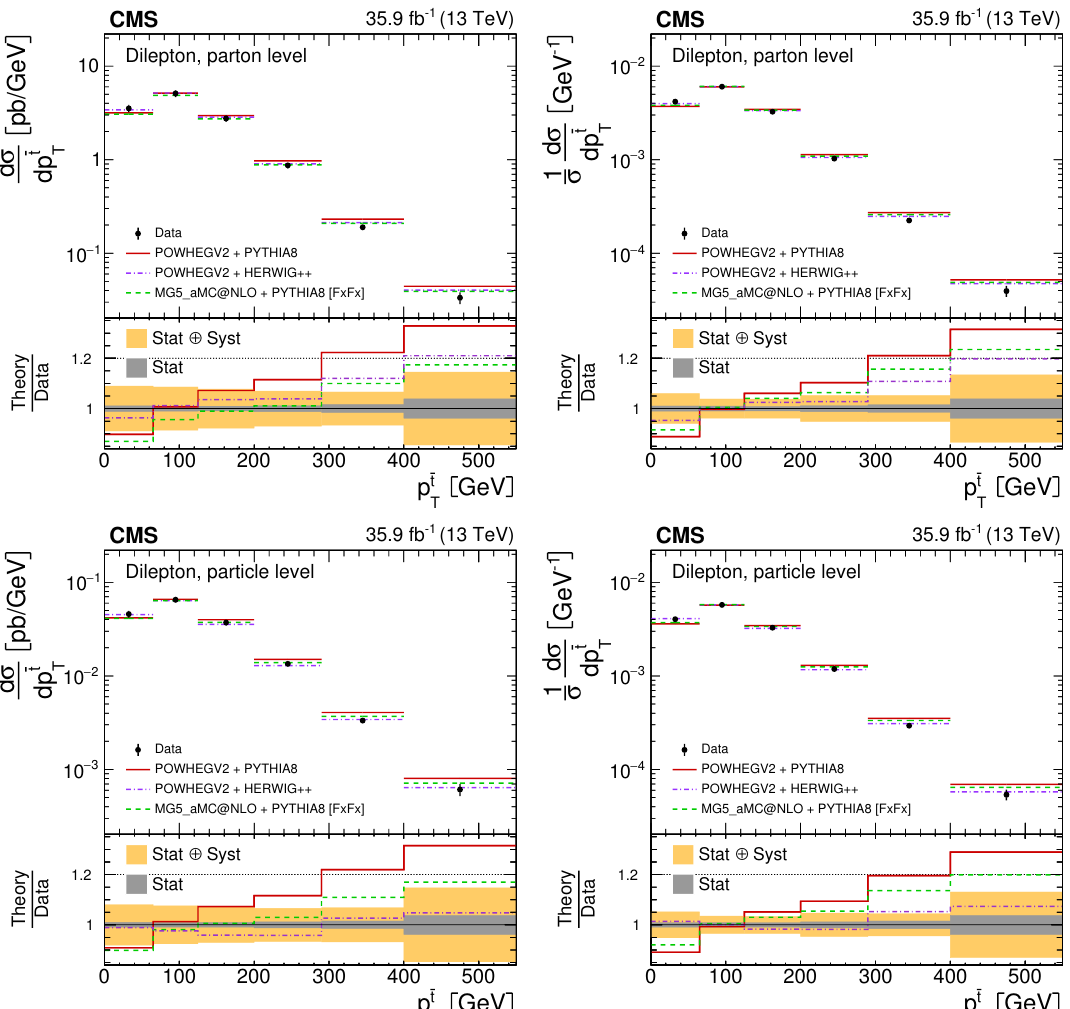
Figure 6 . The di(cid:11)erential tt production cross sections as a function of p t data (points) and the MC predictions (lines). The vertical lines on the points indicate the total uncertainty in the data. The left and right columns correspond to absolute and normalised mea- surements, respectively. The upper row corresponds to measurements at the parton level in the full phase space and the lower row to the particle level in a (cid:12)ducial phase space. The lower panel in each plot shows the ratios of the theoretical predictions to the data. The dark and light bands show the relative statistical and total uncertainties in the data, respectively.